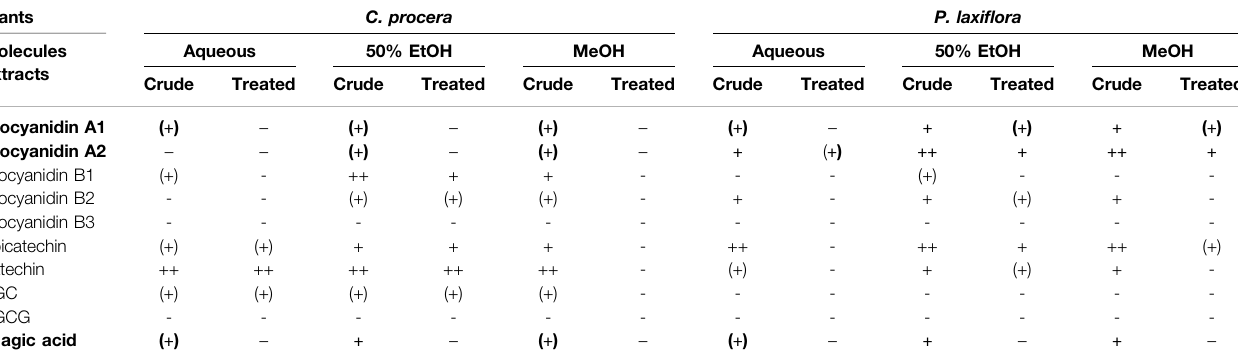
TABLE 3 | Tannins and monomers content of C. procera and P. laxi fl ora extracts before and after tannin removal. For both plants, these molecules were searched in each extract (aqueous, hydro-ethanolic and methanolic) before (crude) and after treatment with hide powder (treated). +: presence; − : absence (no peak detected); (+): trace (peak area just above the noise). Bold: molecules found in all alcoholic (active) crude extracts but not in the treated ones.